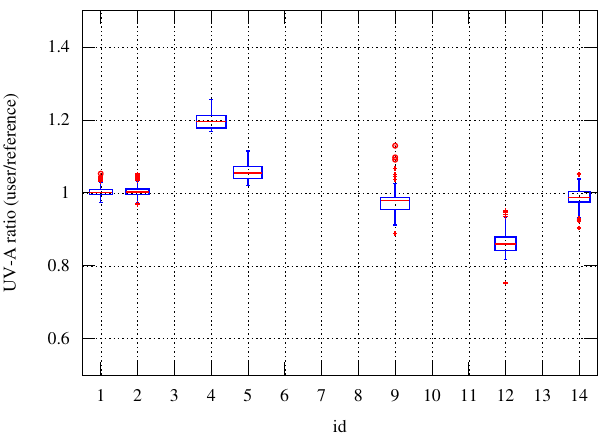
Fig. 6. Boxplot of UV-A irradiance ratios between each instru- ment and the reference, calculated under clear sky conditions. Only instruments measuring UV-A irradiance can be shown in the